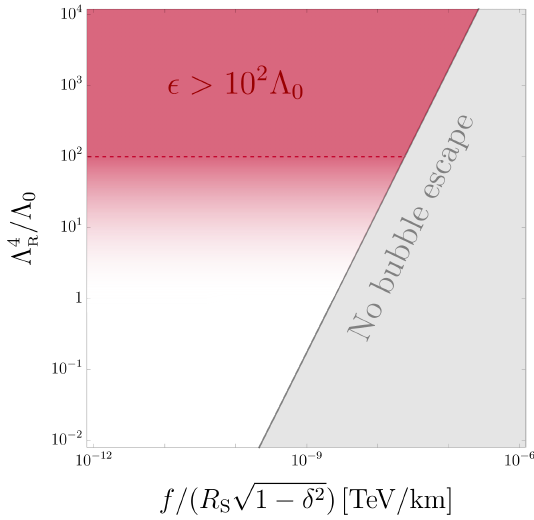
Figure 6: Region excluded by a density induced vacuum instability (shaded red) in (cid:112) / Λ ) , where R the plane ( f / R 1 − δ 2 , Λ 4 is the typical radius of the (type of) star 0 S S R triggering the phase transition, i.e. where densities above critical are realized, n > n The dashed line corresponds to the bound Eq.